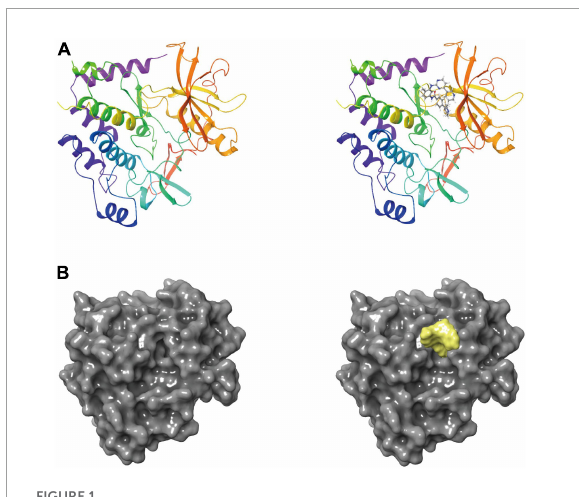
FIGURE1 (A) The molecular structure of platelet-derived growth factor receptor α (PDGFRA), as well as the complex structure of PDGFRA combined with imatinib. (B) A molecular structure of PDGFRA and a complex structure of PDGFRA with Imatinib. Yellow represents Imatinib and gray represents